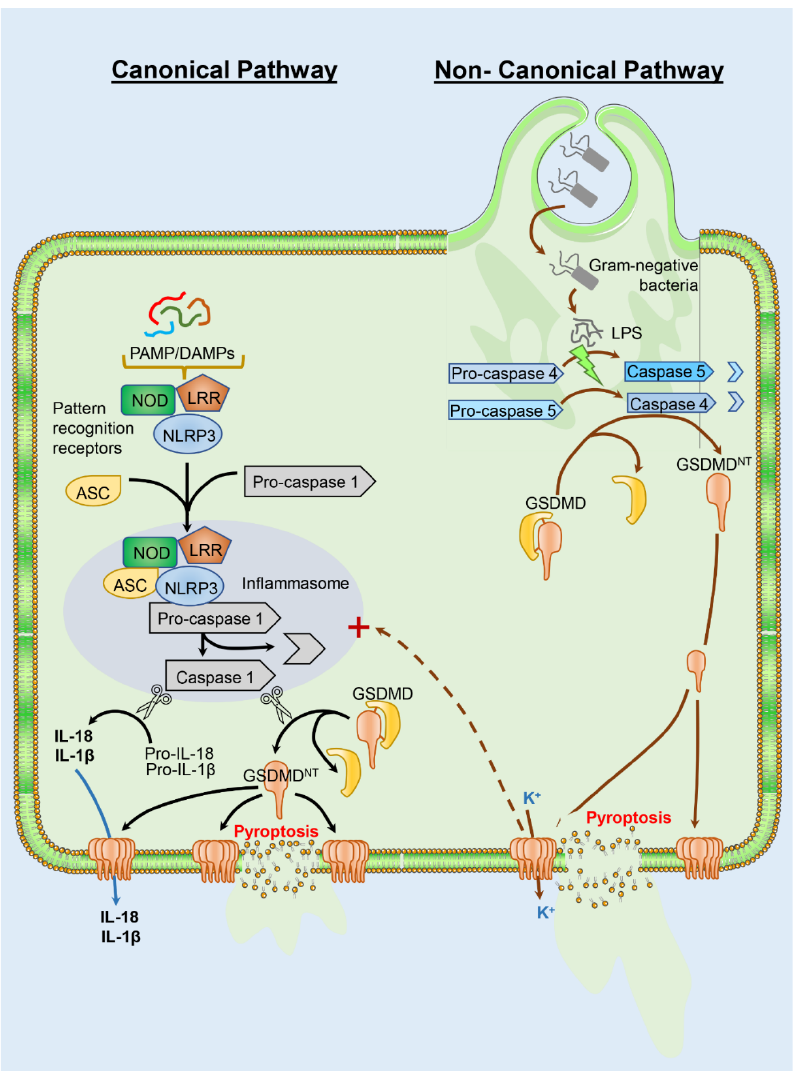
Figure 1. Pathways of pyroptosis. Gasdermin (GSDMD) cleavage and activation are central